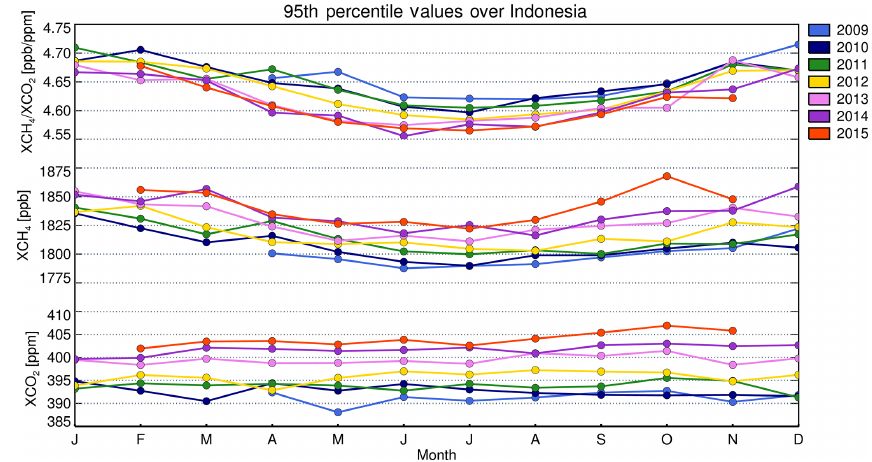
Figure 3. Time series showing the monthly 95th percentile values over Indonesia for the GOSAT Proxy XCH 4 / XCO 2 (top) as well as the individual XCH 4 (middle) and XCO 2 (bottom) components of the Proxy data for the entire GOSAT data record